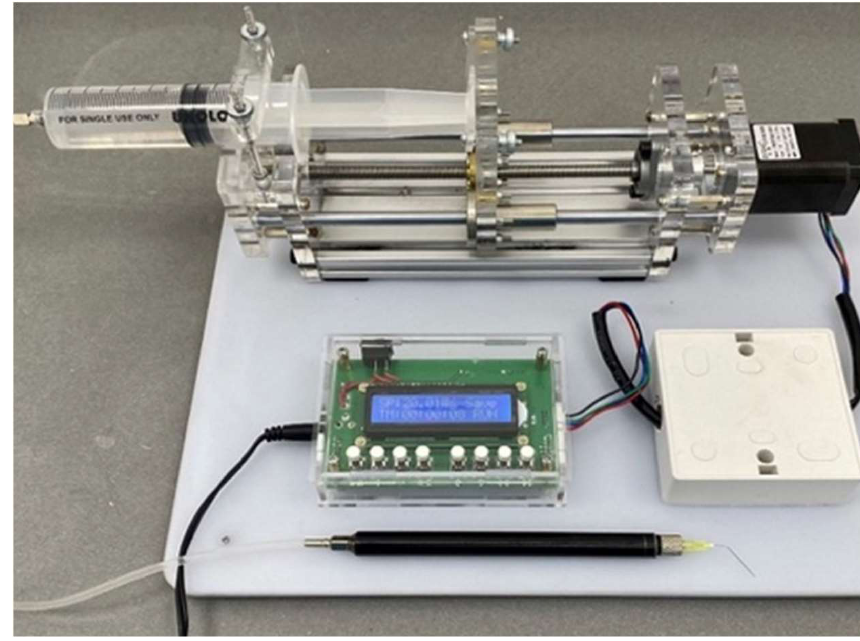
Figure 5. Custom-made device for standardized irrigation.